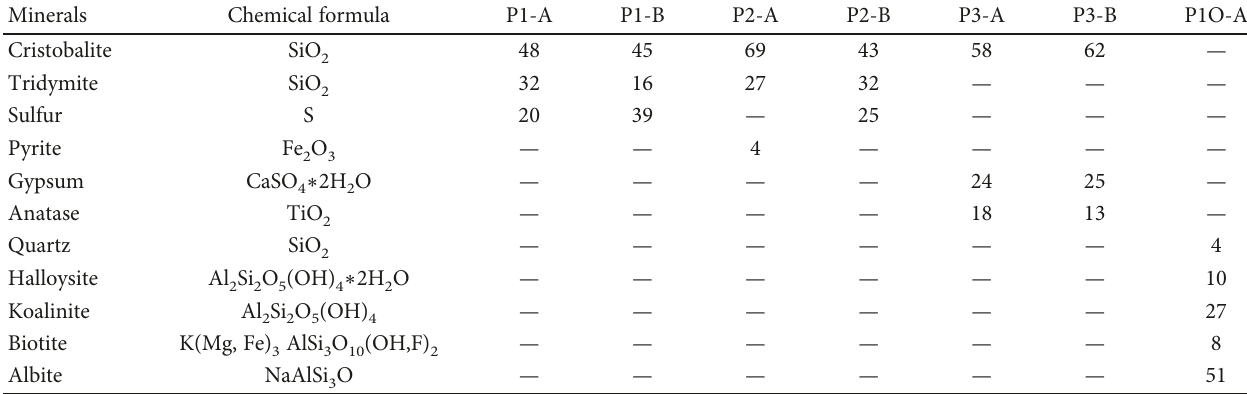
Table 6: Minerals in samples from the Puracé-La Mina